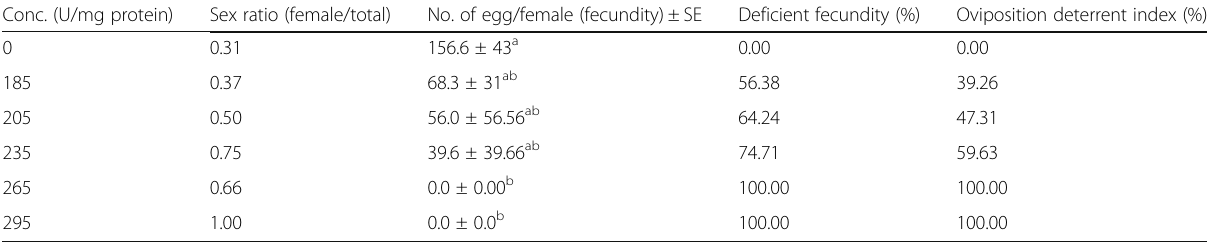
Table 5 Effect of crude chitinase on fecundity and sex ratio of Galleria mellonella , treated as first larval instar Conc. (U/mg